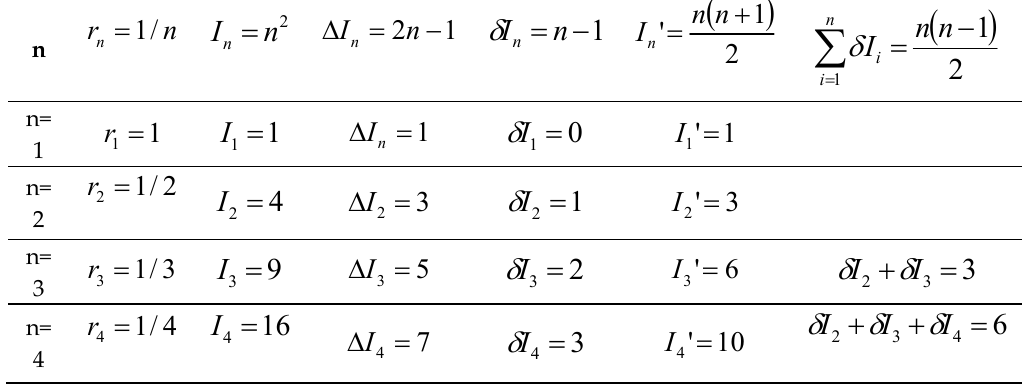
Table A1. The relevant quantities in the attractor’s basin at each level n Values of the radius of the attractor’s basin and of quantum information at each level